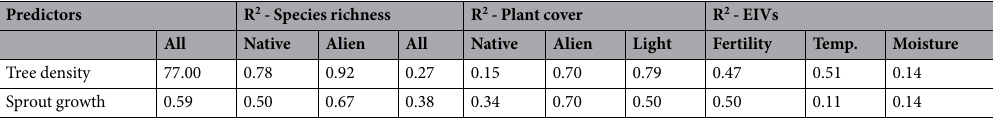
Table 1. Proportion of the variance (R 2 ) in species richness, cover, and Ellenberg indicator values (EIVs) in the forest understory explained by logging-induced changes in tree density and subsequent sprout